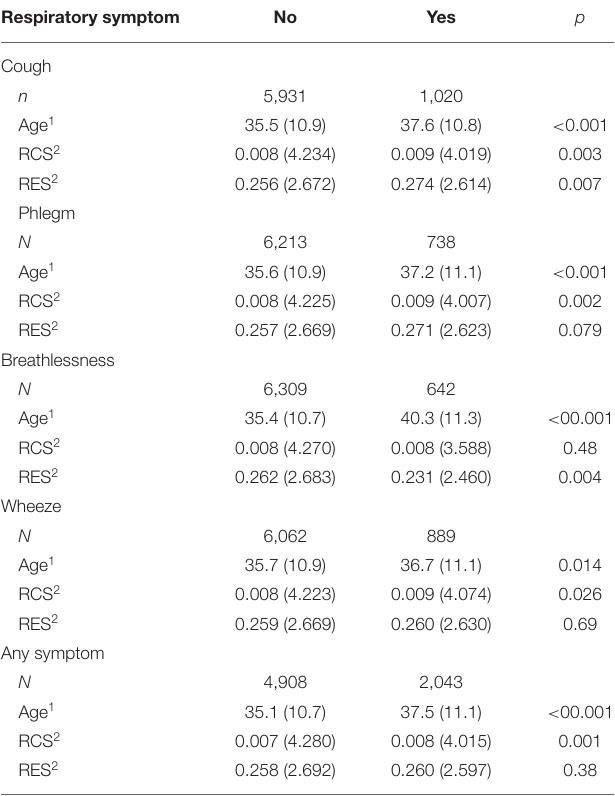
TABLE 2 | Distribution of RCS and RES concentrations (mg/m 3 ) and age (years) of miners by the status of respiratory symptom. Respiratory